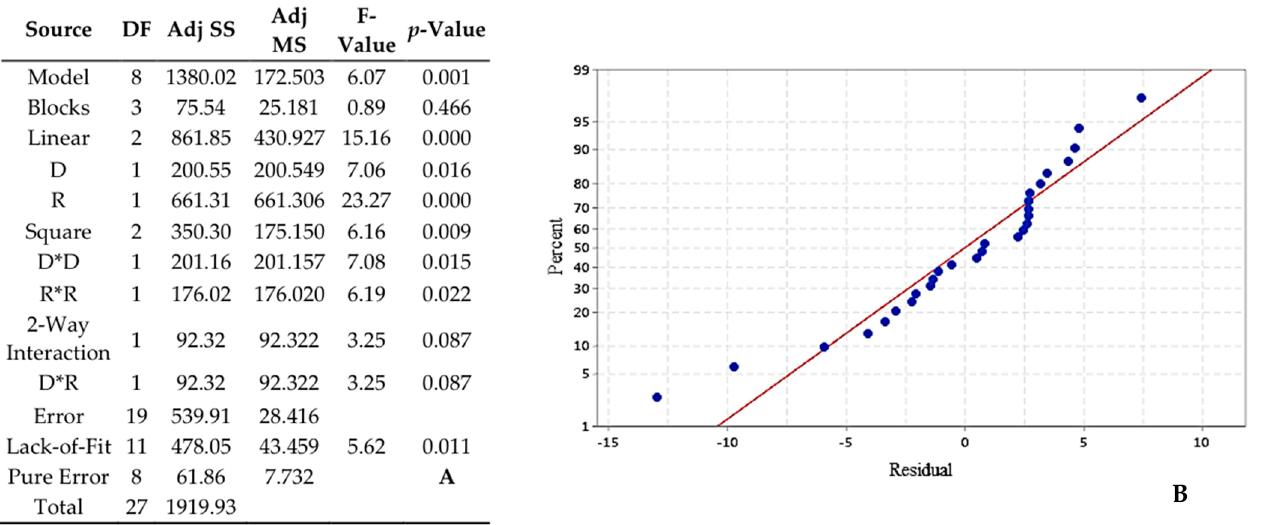
Figure 6. Analysis of variance (ANOVA) for the RSM ( A ) and normal probability plot of the residuals of GD-PAMAM-2/CIT EO ( B ).